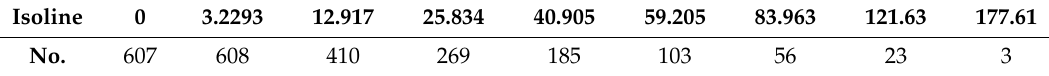
Table 5. Isoline set of the commercial-intersection kernel density surface.